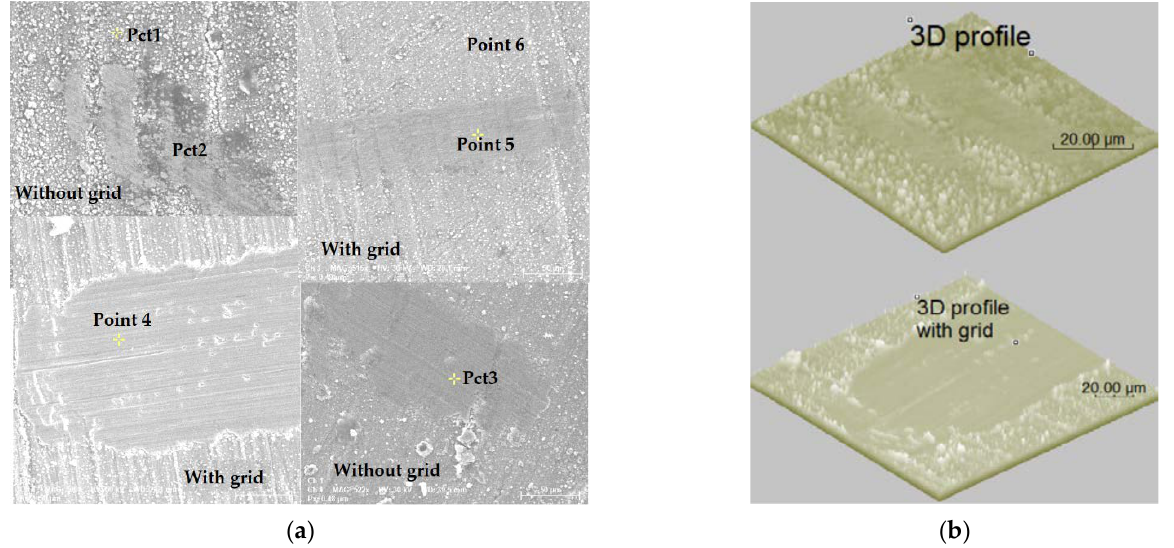
Figure 16. SEM images of the scratch mark on the nitride surface without and with grid and selected areas for the point mode chemical composition (automatic EDS detector). ( a ) SEM micrograph of scratch track profile; ( b ) 3d profile.